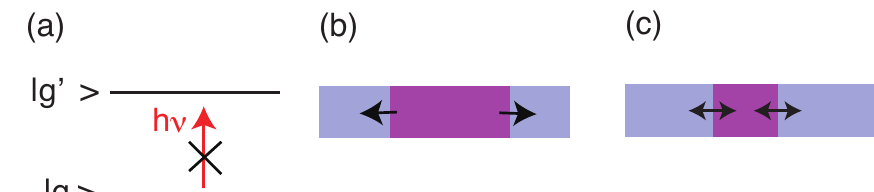
Figure 1. Scenarios of photoinduced electronic phase transitions (PIPTs). ( a ) Direct transition from the ground state of the initial phase to that of another phase. In a bulk system, this is strictly prohibited. ( b ) Domain formation on the phase boundary and ( c ) the formation of a small domain in situations far from the phase boundary. In ( b ), the domain grows persistently in the absence of dissipation, while the growth saturates and a breathing oscillation remains in ( c